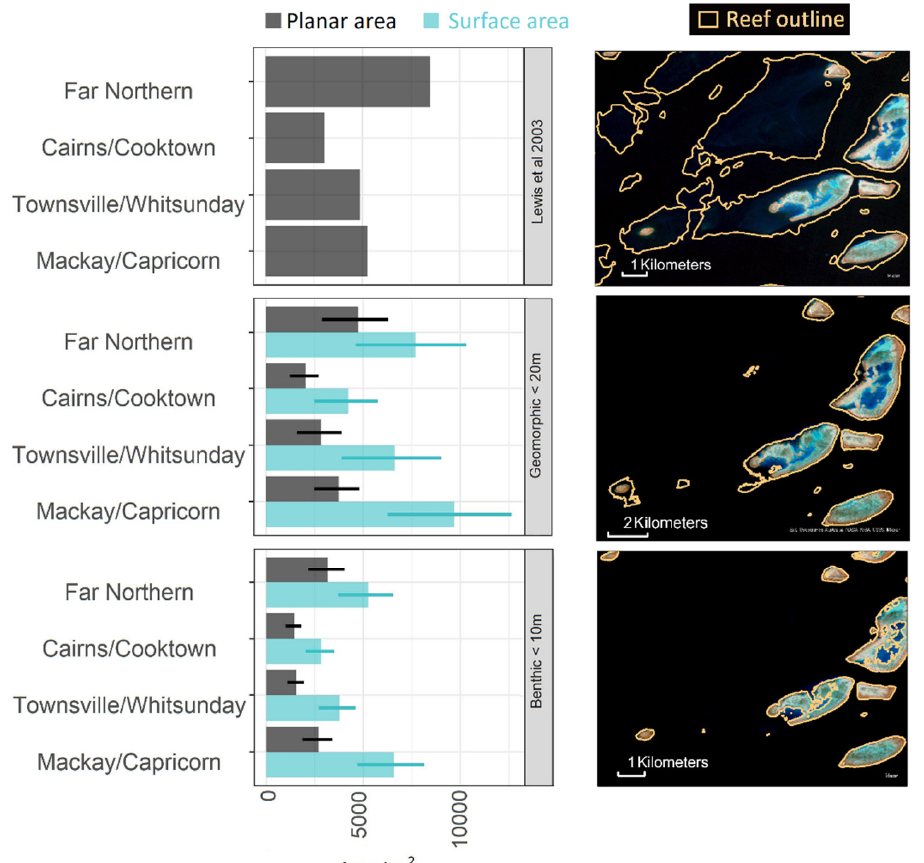
Figure 4. Comparison of 2D planar and 3D surface area (gray and blue bars, respectively) per region. Error bars denote 95% Confidence Intervals. Estimates based on reef outline provided by Lewis et al., 2003 [27] (top panel) compared to this study based on geomorphic zones above 20 m MSL (middle panel) and mapped benthic categories above 10 m MSL (bottom panel). Visualization of respective reef outlines based on mapped areas from the Mackay/Capricorn region overlaid on Sentinel 2 satellite imagery.